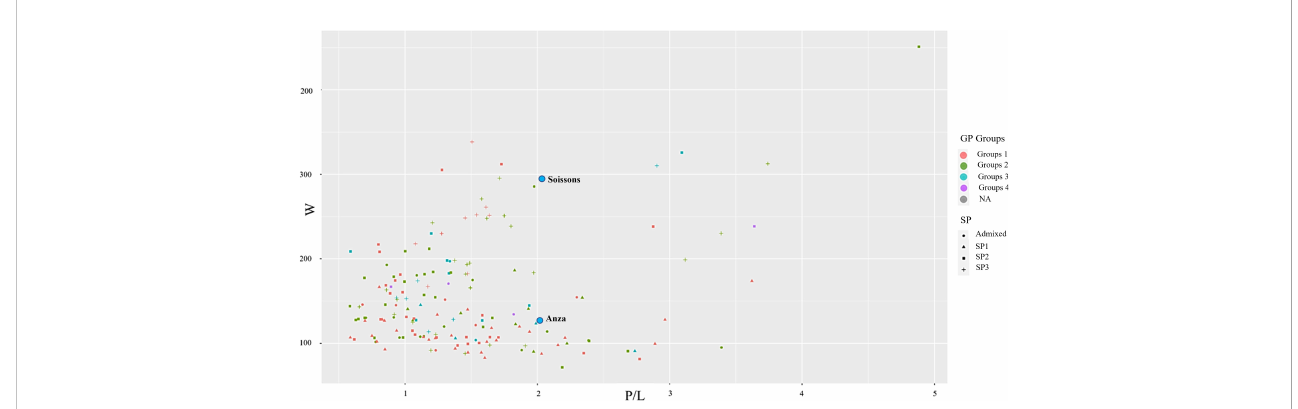
FIGURE 1 Comparison of grain protein concentration with alveograph traits. Grain protein (GP) is coloured based on the quality levels (Group 1 ≥ 13%, Group 2 ≥ 12%, group 3 ≥ 11% group 4>10%), P/L, alveograph tenacity/extensibility ratio (P/L), W Elasticity or strength (J*10 -4 ); NA, not assigned.